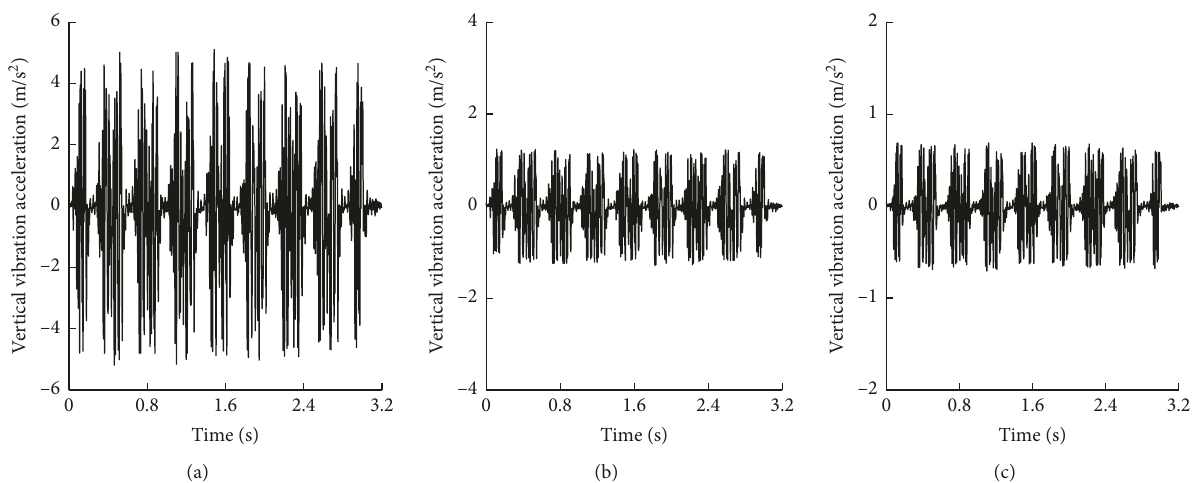
Figure 8: The vertical vibration acceleration history curves of the ballastless track-subgrade under the normal condition ( v (a) The track slab. (b) The concrete base. (c) The subgrade surface.